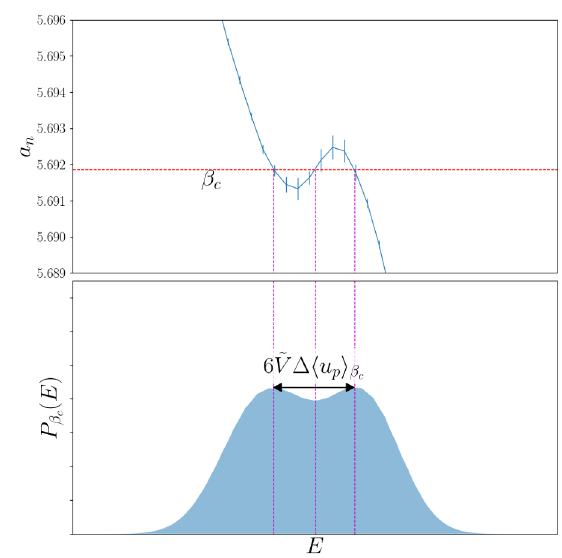
Figure 3. Results of the LLR